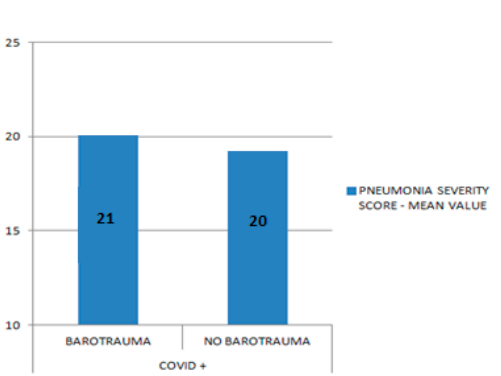
Figure 6. Comparison between barotrauma and pneumonia severity score in COVID+ patients.